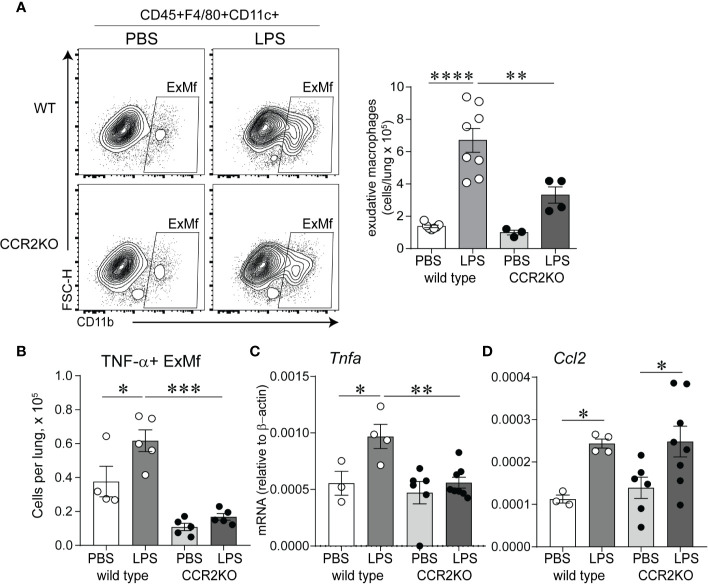
Immature CCR2 knockout mice show an attenuated increase in lung exudative macrophages and lung TNF-α expression following chronic LPS exposure. (A) CD45+F4/80+CD11c+CD11b+ cells, representing exudative macrophages (ExMf) were quantified by flow cytometry. Compared with LPS-exposed wild type mice, CCR2 knockout mice showed a decreased number of ExMf (A), in addition to decreased number of TNF-α+ExMf (B) and total lung TNF-α mRNA expression (C). LPS-induced Ccl2 mRNA expression was not affected by CCR2 deficiency (D). n = 3 to 8 mice per group, *P < 0.05, **P < 0.01, ***P < 0.001, ****P < 0.0001, one-way ANOVA.